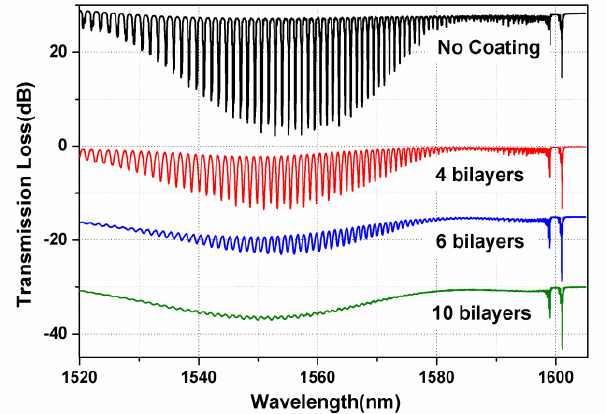
Figure 4. Transmission spectra of 10° TFBG without coating and with 4, 6 and 10 bilayers [(PDDA/PAA) , (PDDA/PAA) , (PDDA/PAA) 4 6 10